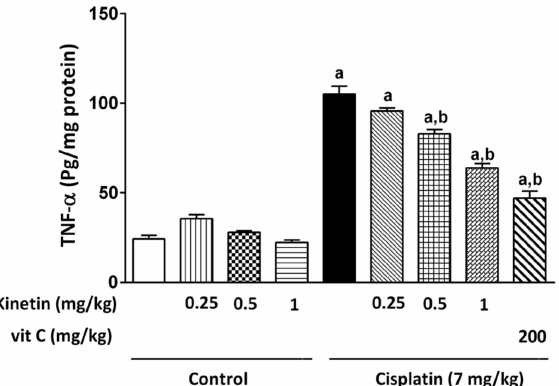
Figure 3. Effect Effect of kinetin on hepatic TNF- α level. Effect of different doses of kinetin and vitamin C on hepatic TNF- α level. a Significantly different from control group, b significantly different from cisplatin group according to one-way ANOVA followed by Tukey–Kramer multiple comparisons test at p < 0.01, ( n = 6). Tests were performed as described in Research Design and Methods. TNF- α : Tumor necrosis factor- α , Vit C: vitamin